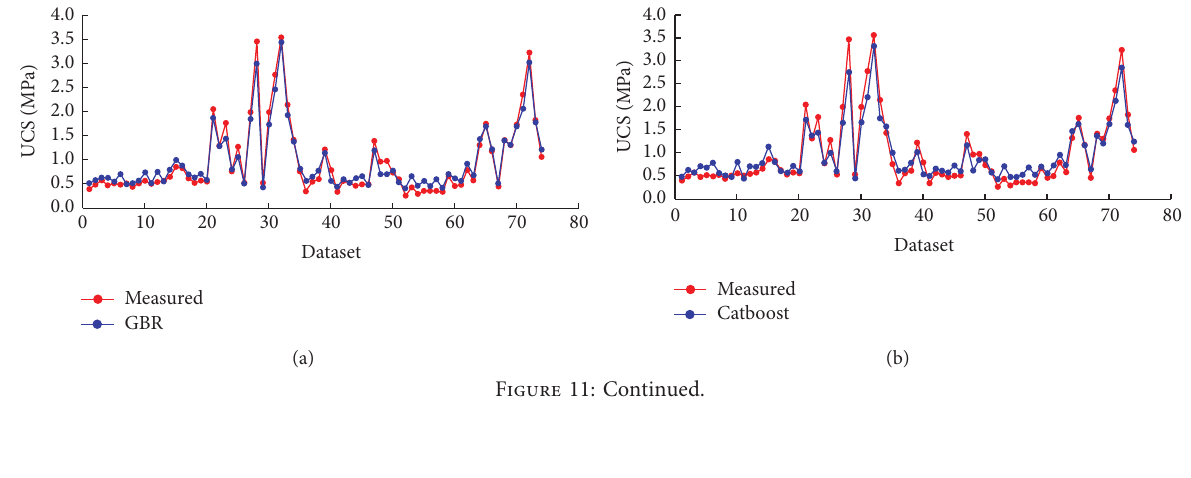
Figure 10: Scatter plots of predicted UCS as opposed to measured UCS of different models in the testing stage: (a) GBR, (b) Catboost, (c) LightGBM, and (d)